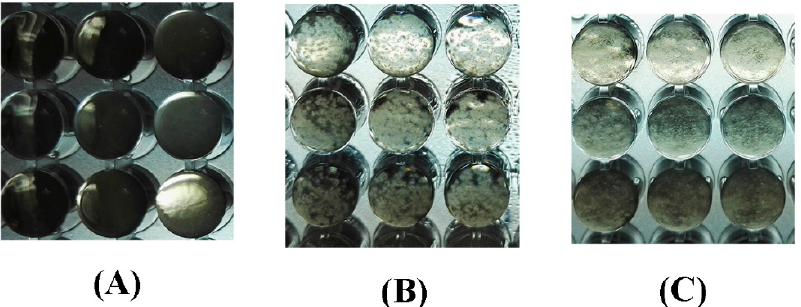
Figure 2. ( A ) Complete antifungal effect. ( B ) Growth effect of fungal strains: Trichophyton rubrun . ( C ) Growth effect of fungal strains: Trichophyton mentagrophytes .